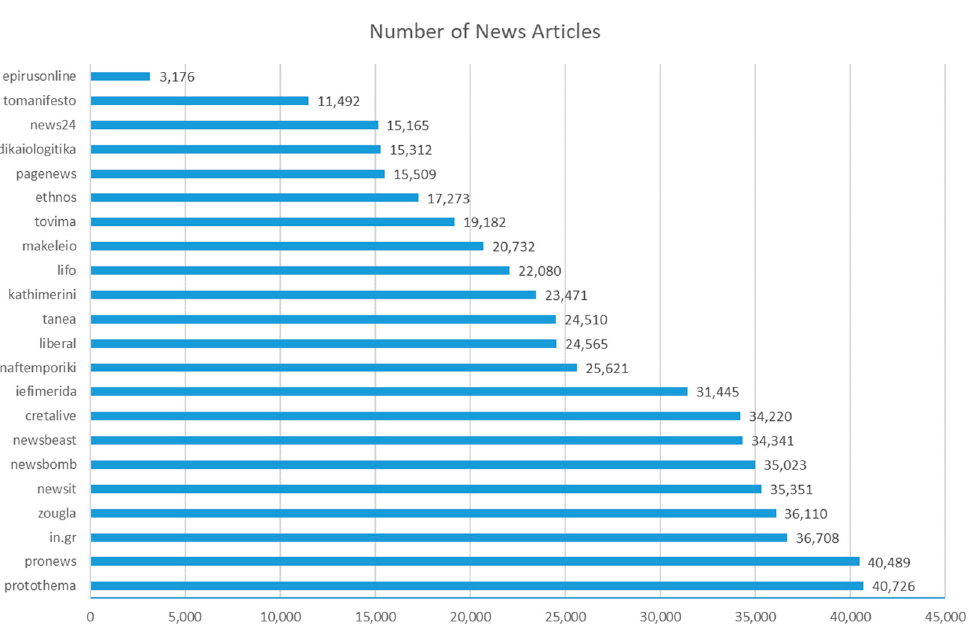
Figure 3. Total number of articles per media website.